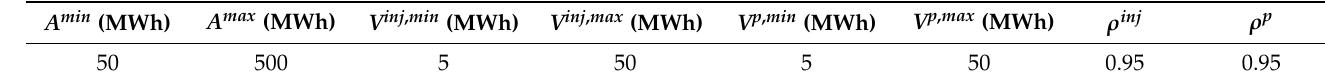
Table 2. Parameters of the CAES unit.